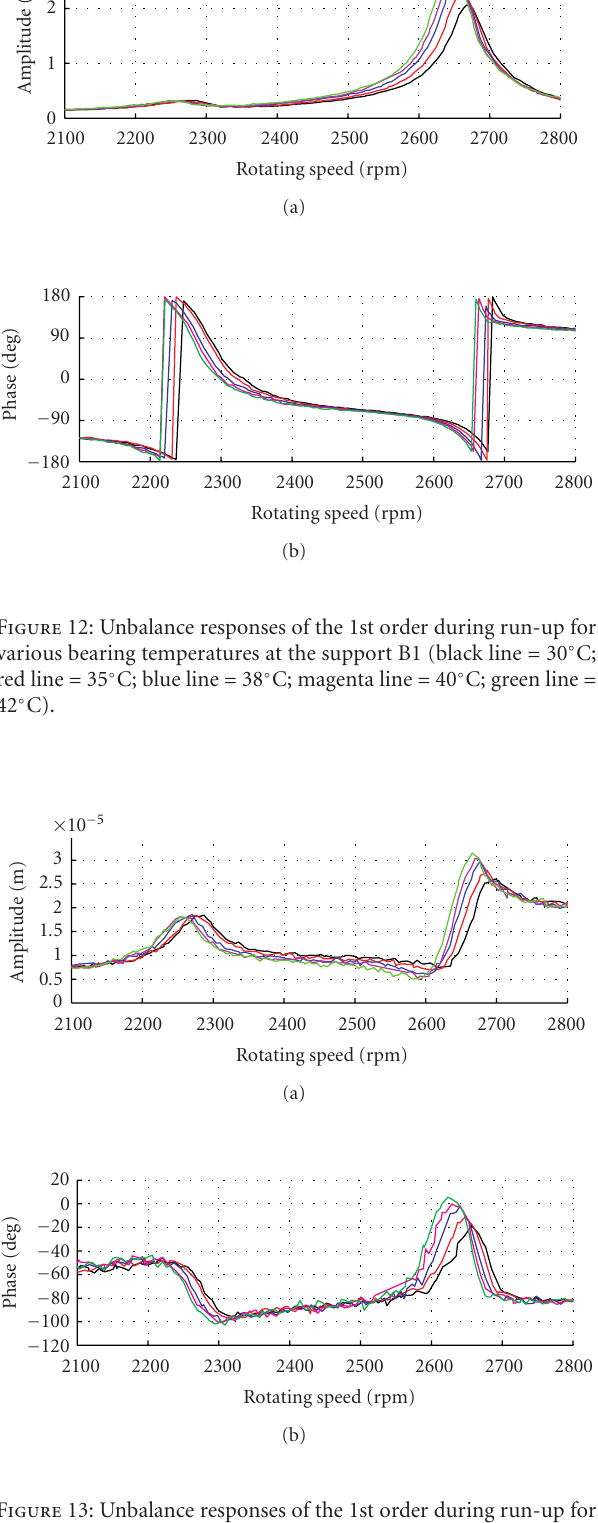
Figure 13: Unbalance responses of the 1st order during run-up for various bearing temperatures at the location plane A3 (black line = 30 ◦ C; red line = 35 ◦ C; blue line = 38 ◦ C; magenta line = 40 ◦ C; green line = 42 ◦ C).